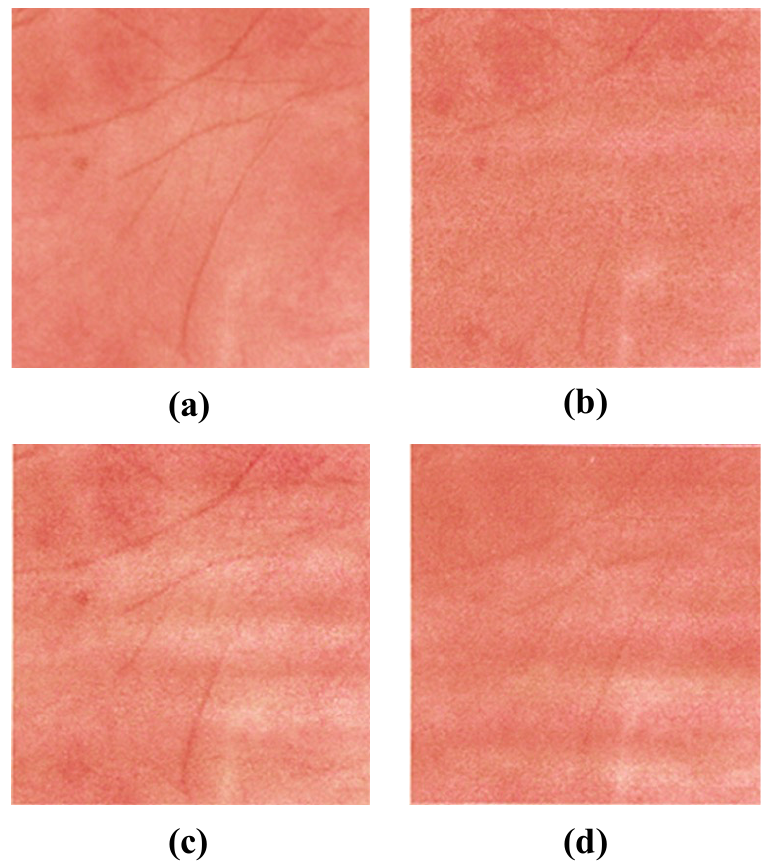
Figure 9. Results of fabrication using the three methods: ( a ) the target image; ( b ) result using the LUT; ( c ) result using multiple regression analysis; ( d ) result using the neural network. Compared to the original appearance, it can be seen that the fidelity of each method is different. Qualitatively, it is observed that the sample achieved by multiple regression analysis has a high reproducibility.